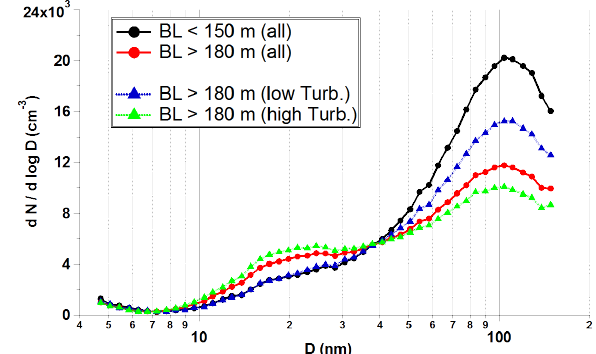
Figure 7 : Average nano-SMPS size distributions at the BT Tower site for periods of: UBL height below the BT Tower sampling height (< 150 m); high UBL height (> 180 m); low σ w2 (< 0.5 m 2 s - 2 ) and high σ w2 (> 0.5 m 2 s -2 ). Measurements of UBL height and σ w2 were derived from the Lidar, using Z MH as the measure of UBL depth.